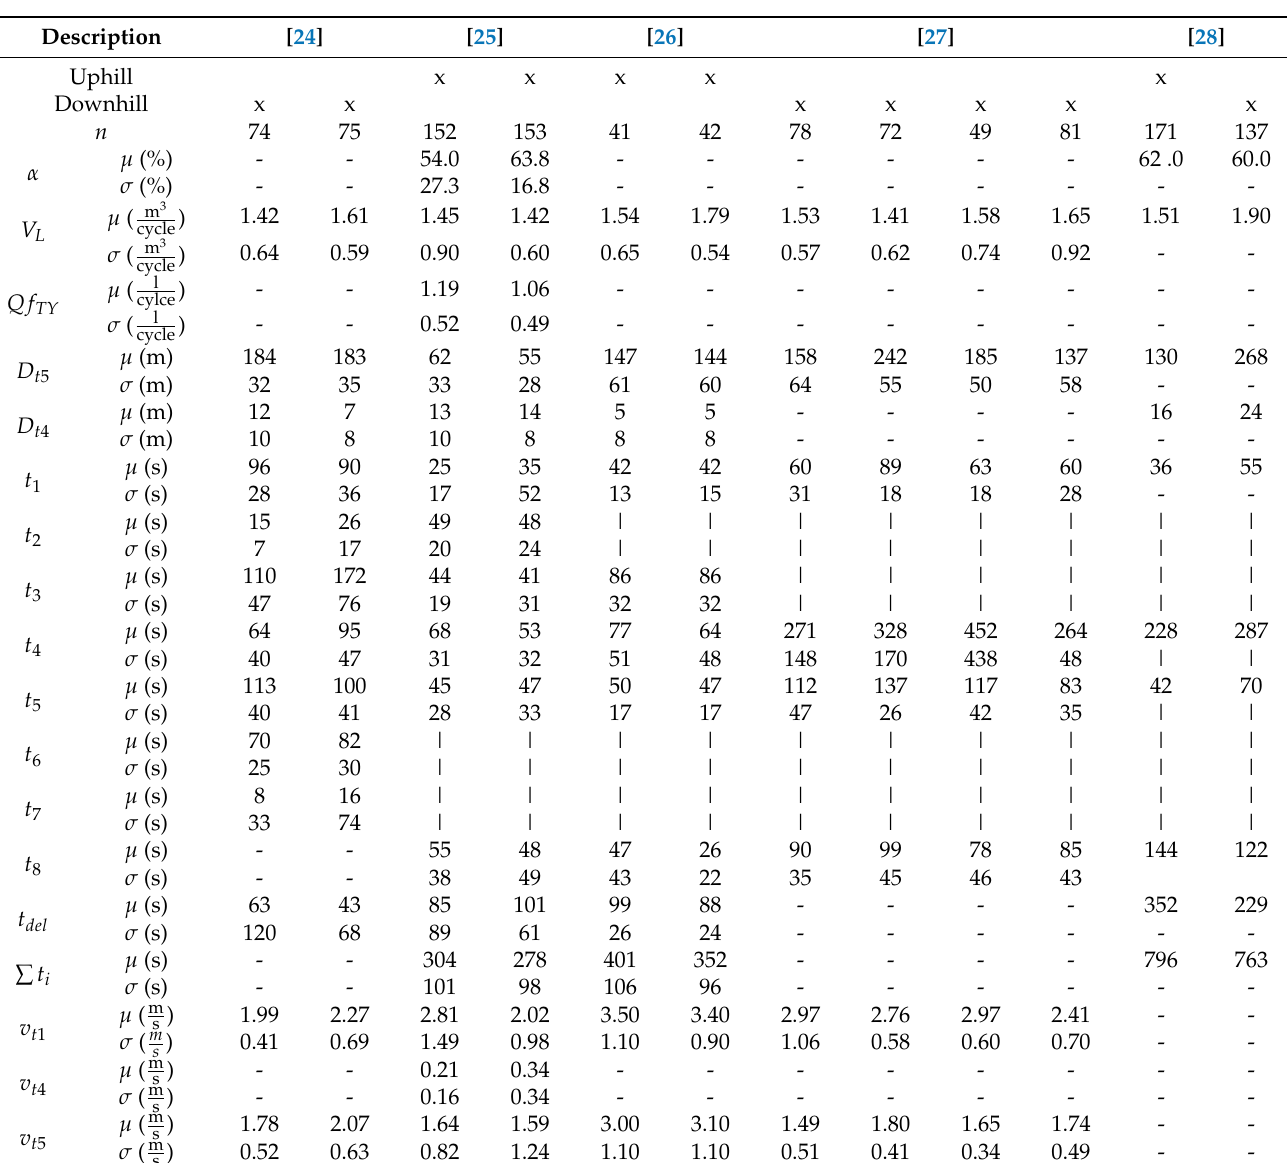
Table 3. Operation data of TY logging systems in various configurations. “x” indicates whether the given setup is an uphill or downhill configuration.“-” indicates that the data were not available. “|” indicates that no individual datum was available, but that the first value below it is the sum of all values labeled as “|” above. For example, in column three, the values given in row t 8 (55 s, 38 s) correspond to the values of t 6 – t 8